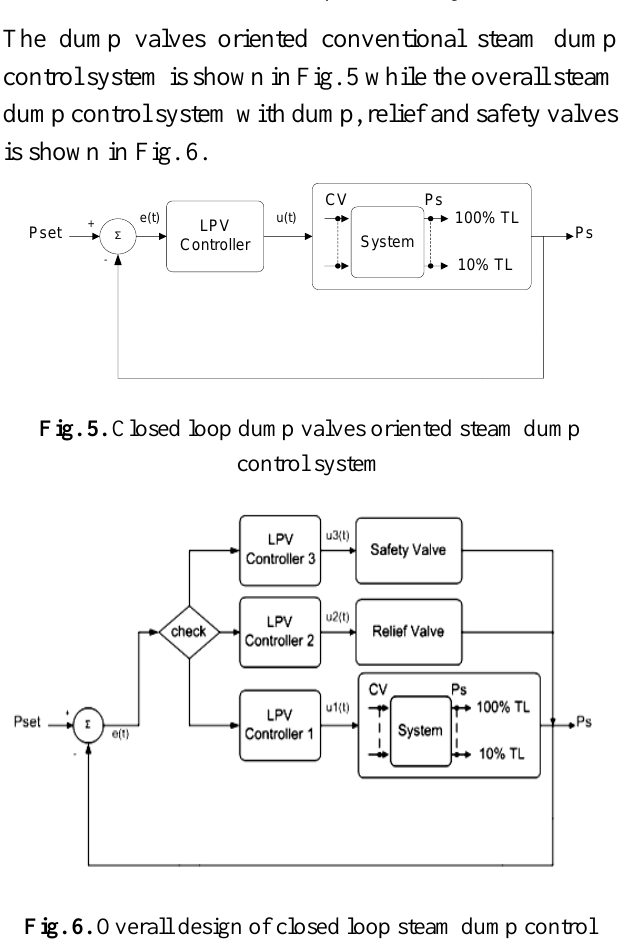
Fig. 6. Overall design of closed loop steam dump control system